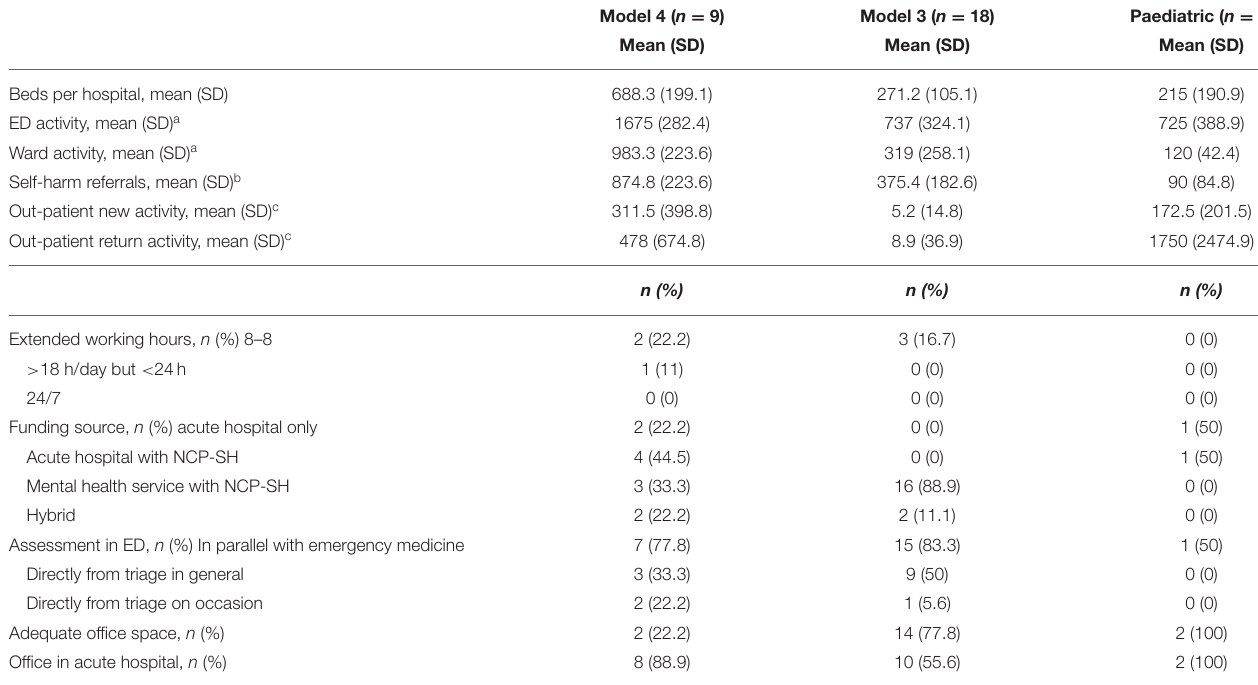
TABLE 2 | Characteristics of Model 3, Model 4, & Paediatric hospitals in Ireland, activity, and models of